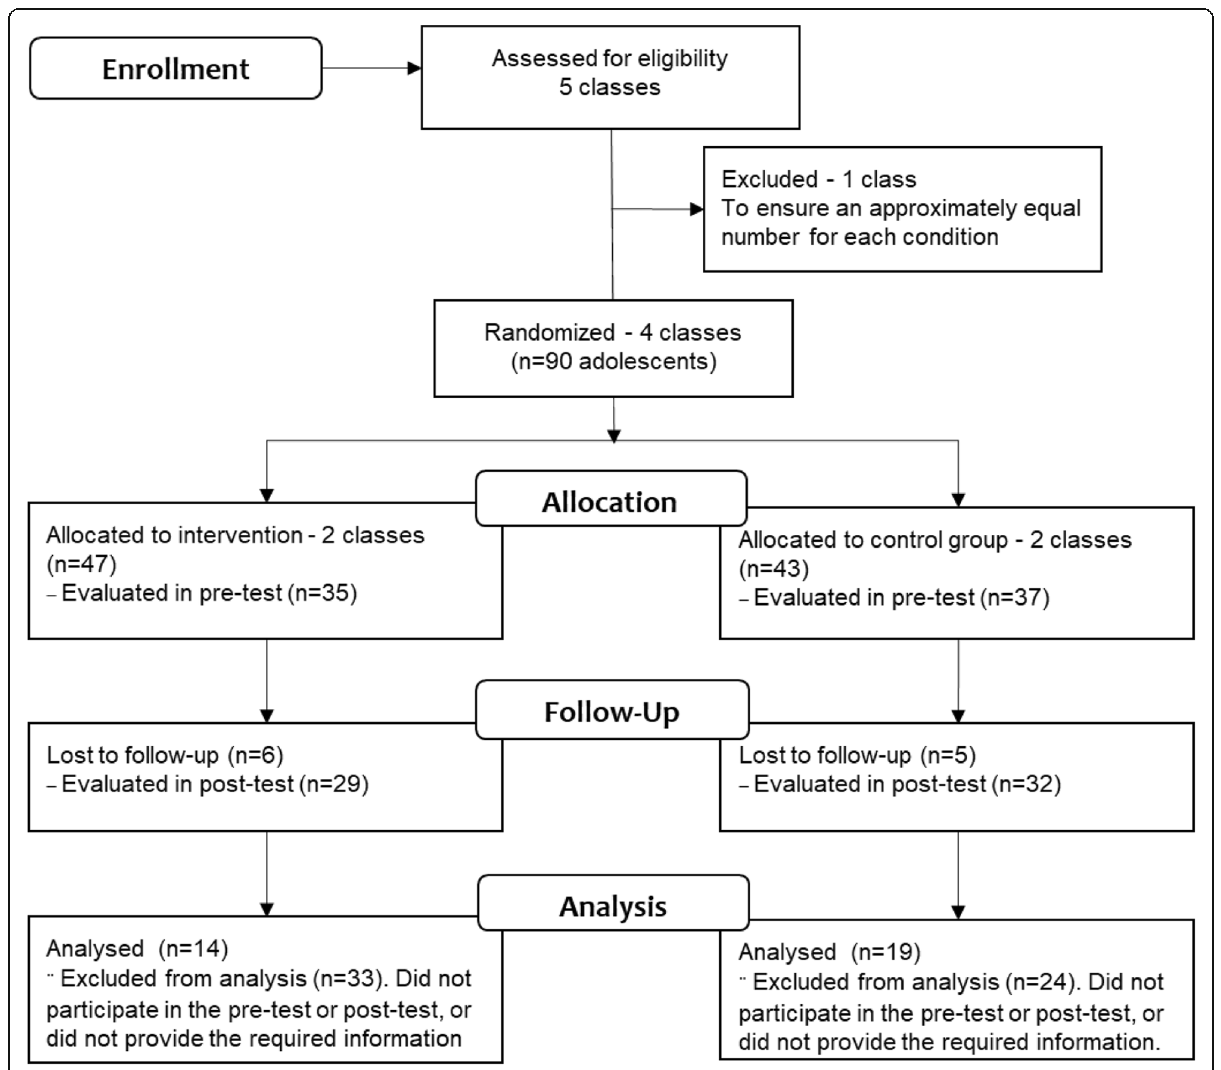
Fig. 2 Flowchart of participants during each stage of the